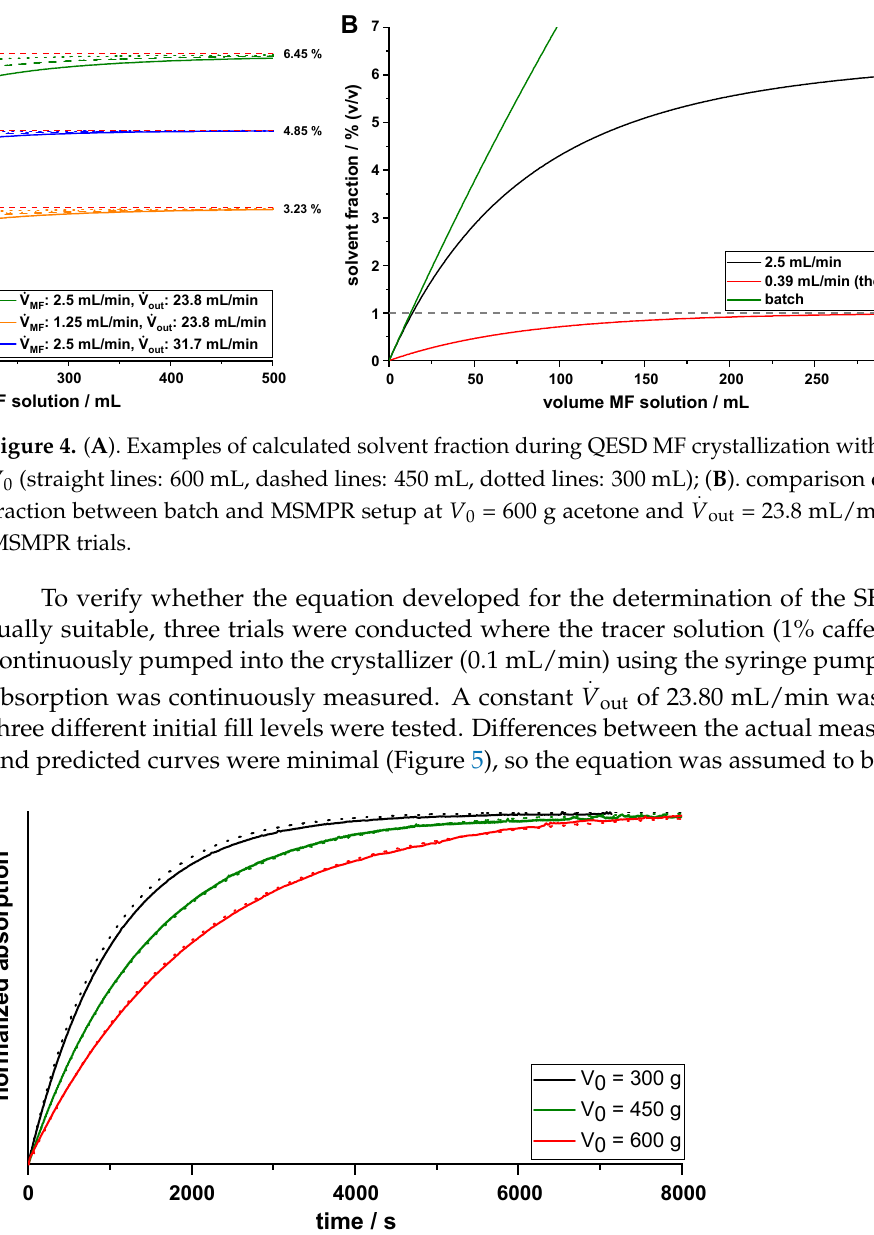
. V out = 23.80 mL/min, and three different